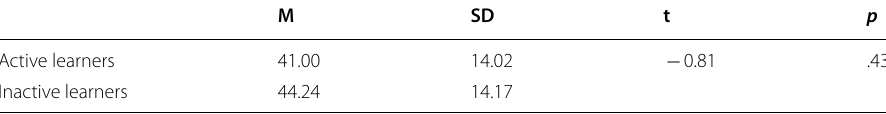
Table 2 Difference between DRT Clusters on Performance M SD t p Active learners 41.00 14.02 0.81 .43 − Inactive learners 44.24